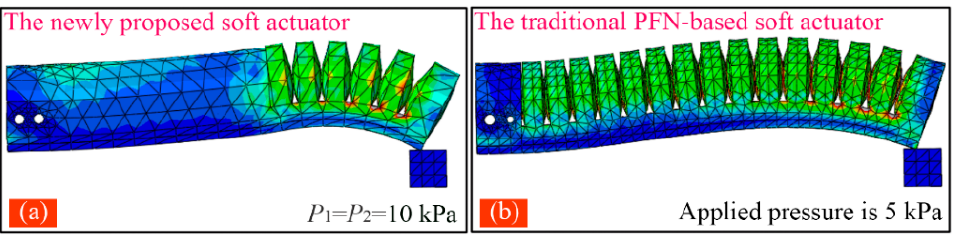
Figure 8. Bending deformation of the proposed soft actuator under different pressures.